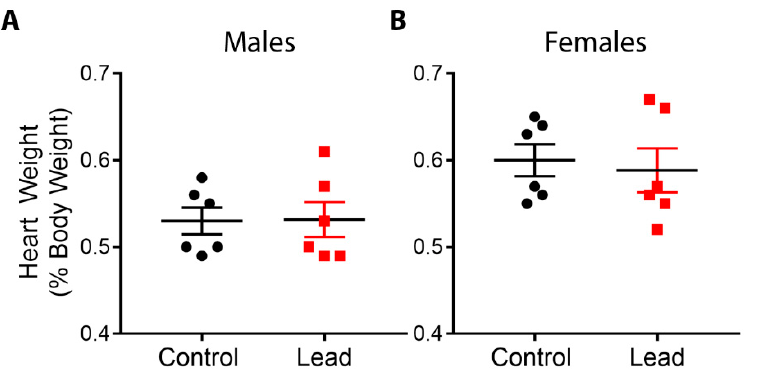
Figure 2. Heart weights, expressed as a percentage of body weight, were assessed for males ( A ) and females ( B ) at 5 months of age. Data were analyzed using linear mixed-effects regression with litter-specific random effects to account for within-litter correlation. Black dots represent control animals and red squares depict Pb-treated animals. There were no statistically significant differences in hearts from Pb-exposed animals compared to controls.